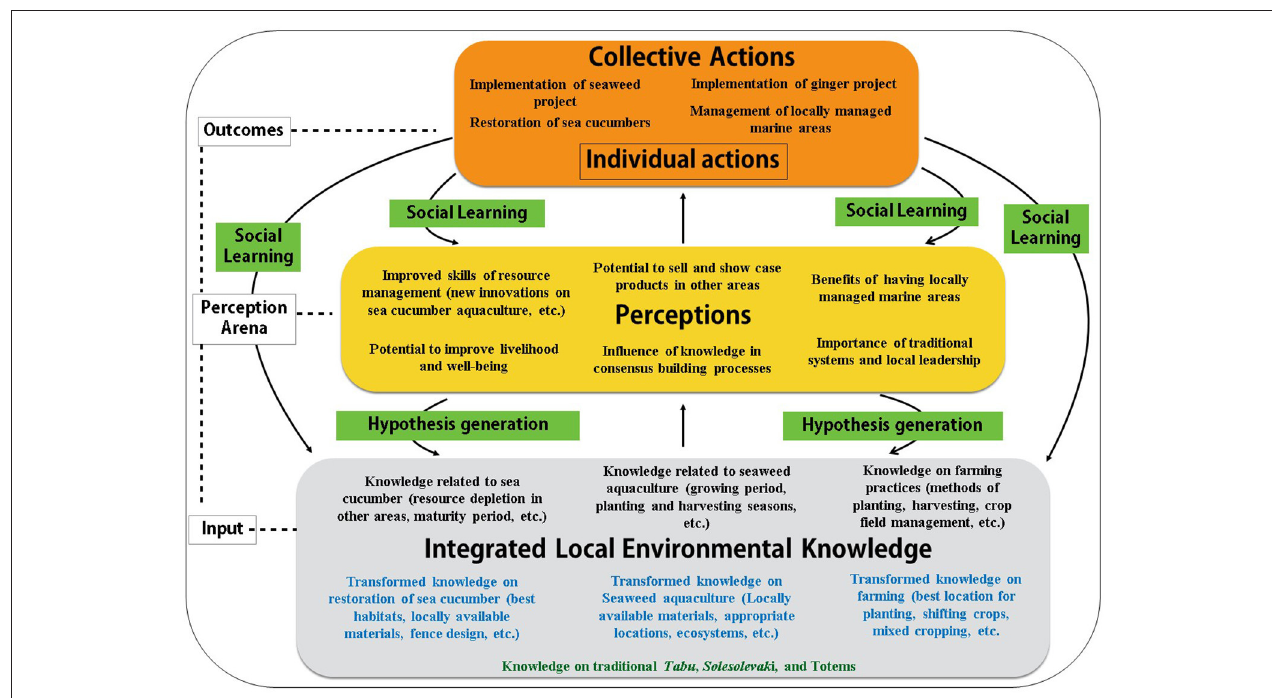
FIGURE 4 | Components of integrated local environmental knowledge and perceptions of people leading to relevant collective actions (see text for